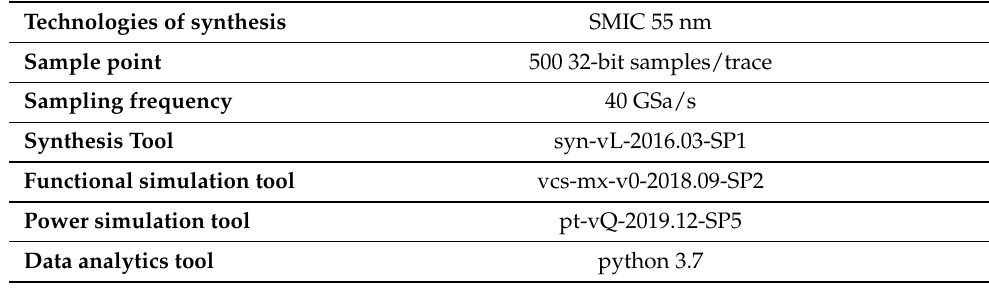
Figure 9. Experimental environment and experimental flow. Table 5. Experimental environment